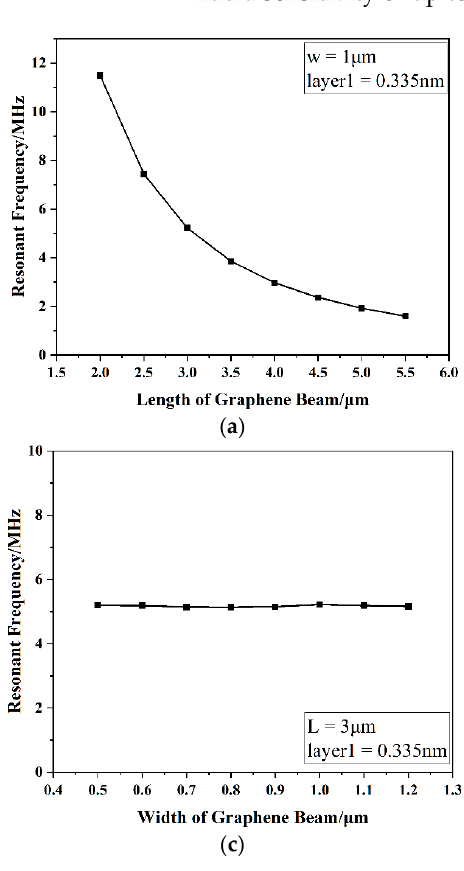
Figure 7. Influence of the graphene resonant beam structure size on the frequency output: ( a ) the relationship between the length of the graphene beam and resonant frequency; ( b ) the relationship between the thickness of the graphene beam and resonant frequency; ( c ) the relationship between the width of the graphene beam and resonant frequency.